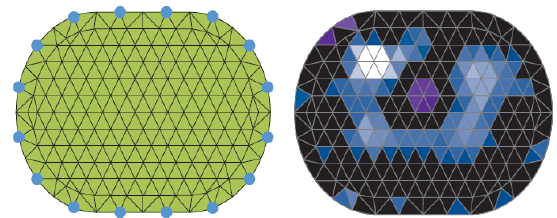
Fig. 4: FEM reconstruction, Left: 2D mesh with 340 finite elements for 16 surface electrodes. Right: FEM-based reconstruction of the bioimpedance distribution.